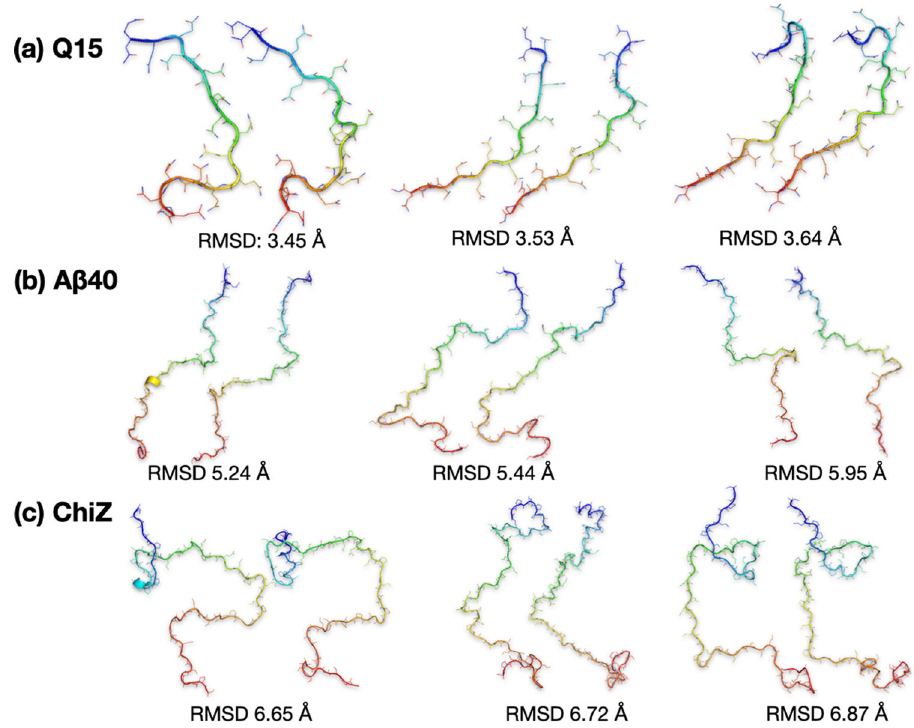
Fig. 6 Comparison of test conformations and their generated best matches after re fi nement. a Q15. b A β 40. c ChiZ. Each IDP is represented by three pairs of conformations with RMSDs around the average best-match value of the diluted test set against the fi nal generated set. In each pair, the left conformation is from the test set and the right conformation is from the generated set, after re fi nement. The unre fi ned versions of the fi rst pair in a , the third pair in b , and the third pair in c are shown in Figs. 4a, b, and 5b, respectively.